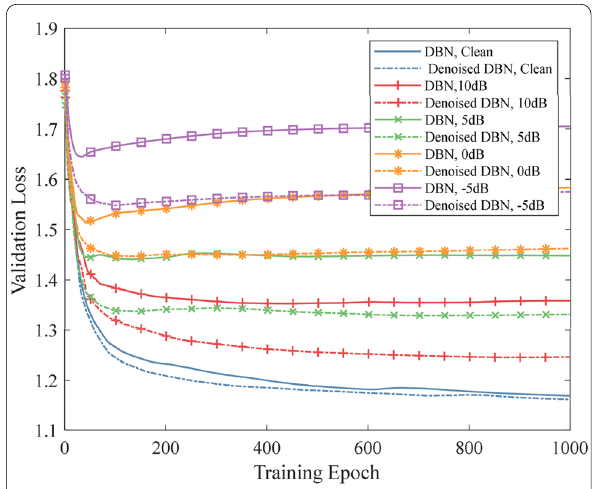
Figure 5 Variance of the validation loss based on